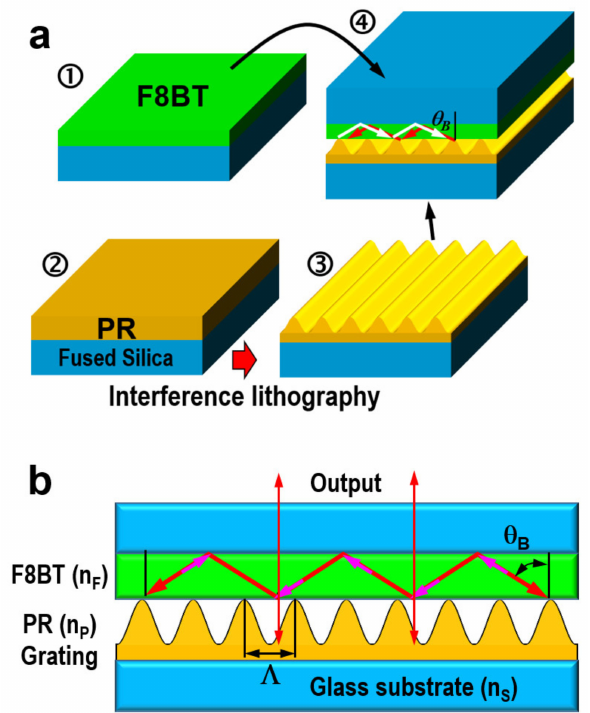
Figure 1. ( a ) Preparation of the mechanically contacted DFB microcavity: ( 1 (cid:13) ) spin-coating of a high-quality F8BT thin film on a fused silica substrate; 2 (cid:13) spin-coating of photoresist (positive, S1805) onto another piece of fused silica substrate; ( 3 (cid:13) ) interference lithography to produce a nanograting into the photoresist; ( 4 (cid:13) ) clamp the two finished structures in ( 1 (cid:13) , 3 (cid:13) ) by a face-to-face configuration to accomplish the design of a DFB laser device. ( b ) Schematic illustration of the basic principles for the mechanically contacted